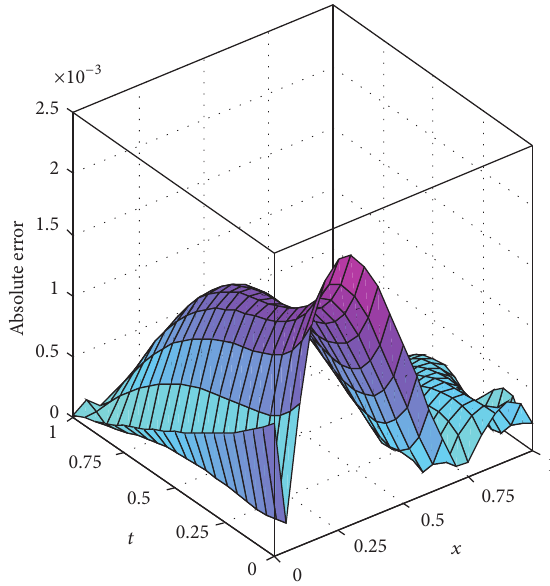
Figure 11: The absolute error for Example 3 with 𝑚 = 𝑛 = 9 .